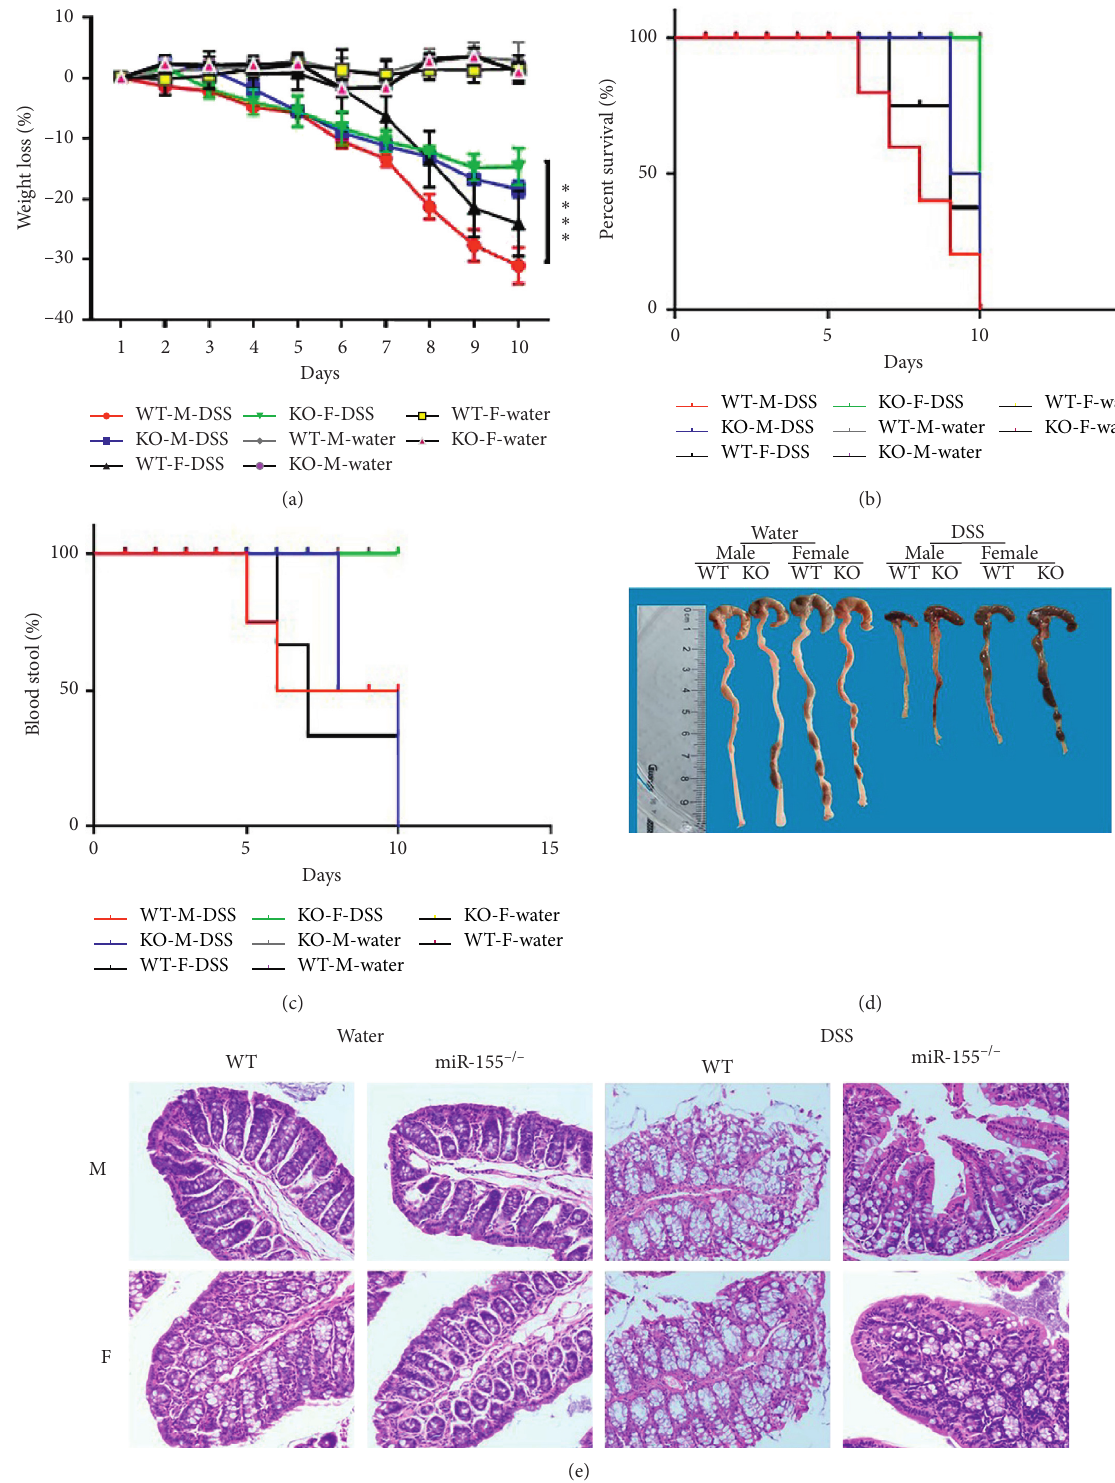
Figure 4: Knock-out of MiR-155 could attenuate the intestinal inflammation in 3% DSS-induced colitis. (a) Weight change, (b) Kaplan–Meier survival rate plot, (c) bloody stool, (d) representative gross colon appearance and colon length, and (e) representative H&E- stained colon cross sections (original magnification, 200 ×